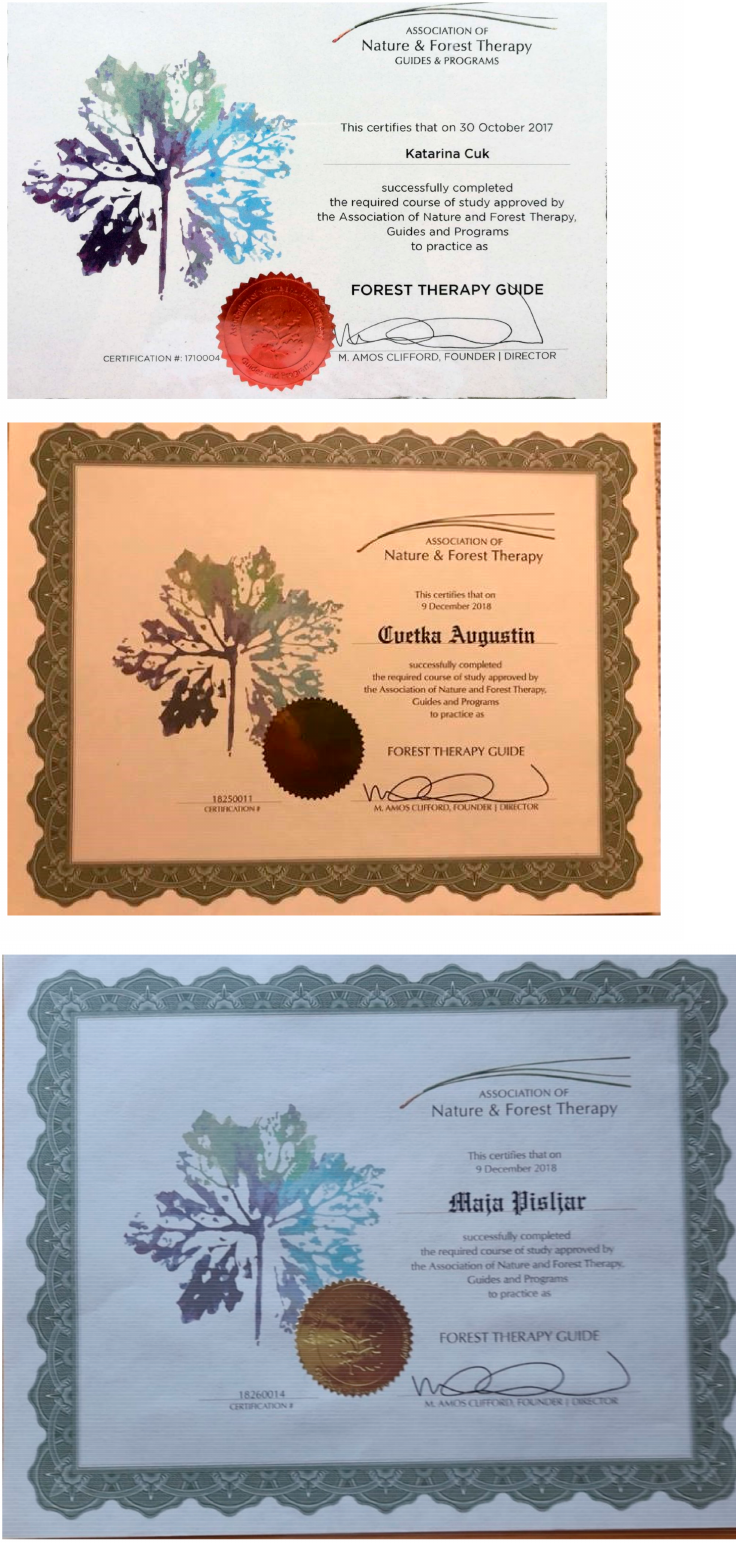
Figure A1. The Association of Nature and Forest Therapy (ANFT)—4 Certificate for Forest Therapy guides, participating in this